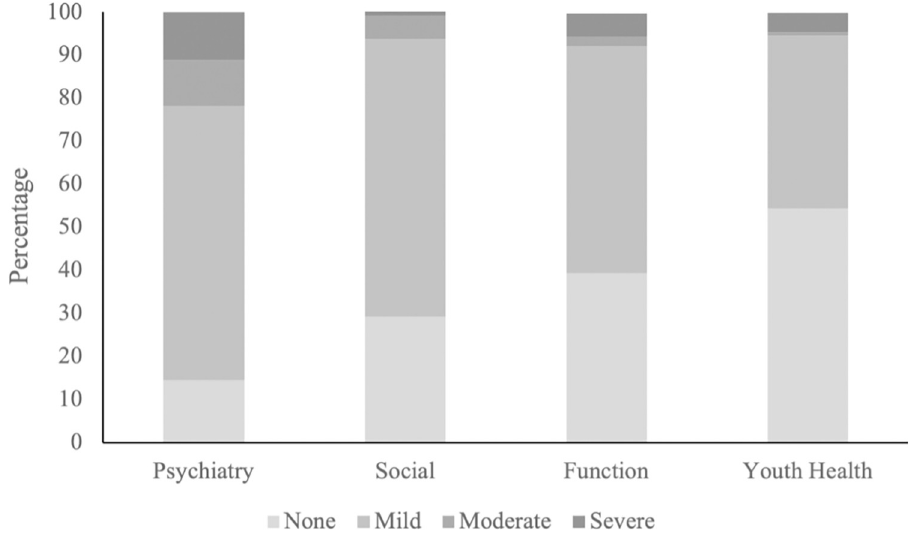
Fig 2. Domain severity based on either guardian or youth